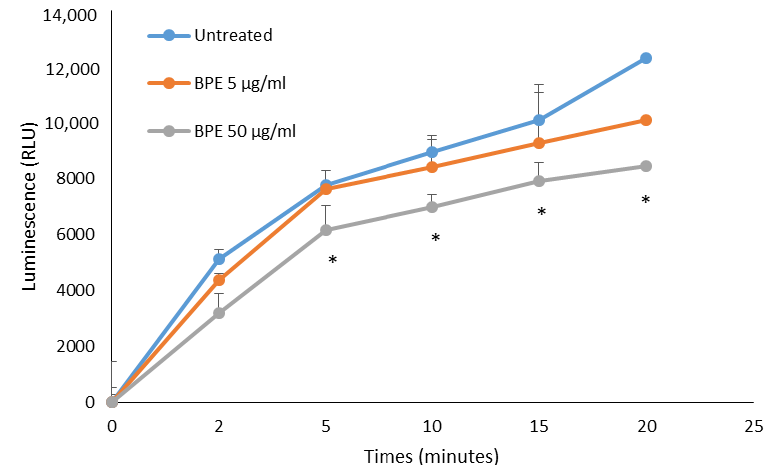
Figure 13. In vitro neutralization of ROS produced by human PMA-stimulated PMN. Results are expressed in relative luminescence units (RLU). Data represent the mean of three independent experiment performed in triplicate for BPE at two different concentrations. The statistical analysis was performed with a two-tailed Student ’s t- test. * p < 0.05 (BPE-treated cells vs. untreated cells).